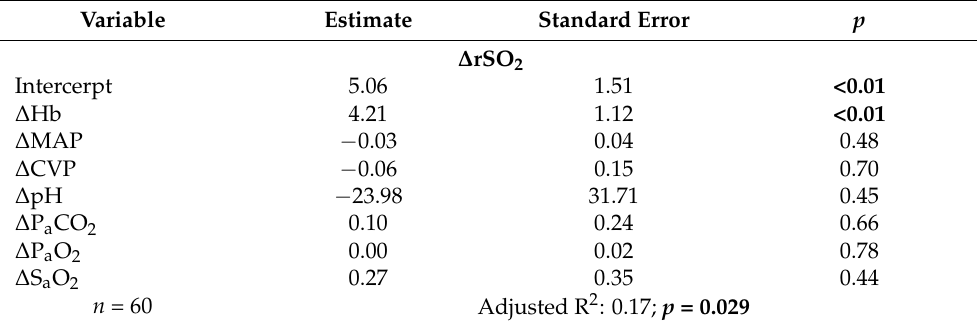
n = 60 Adjusted R 2 : 0.17; p = 0.029 rSO 2 = regional cerebral oxygen saturation; Hb = hemoglobin; MAP = mean arterial pressure; CVP = central venous pressure; FiO 2 = inspirational oxygen fraction; PaO 2 = arterial partial pressure of oxygen; PaCO 2 = arterial partial pressure of carbon dioxide; SaO 2 = arterial oxygen saturation; SpO 2 = partial oxygen saturation; LVEF = left ventricular ejection